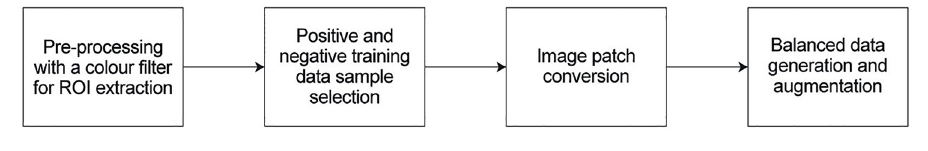
Fig 8. CNN training